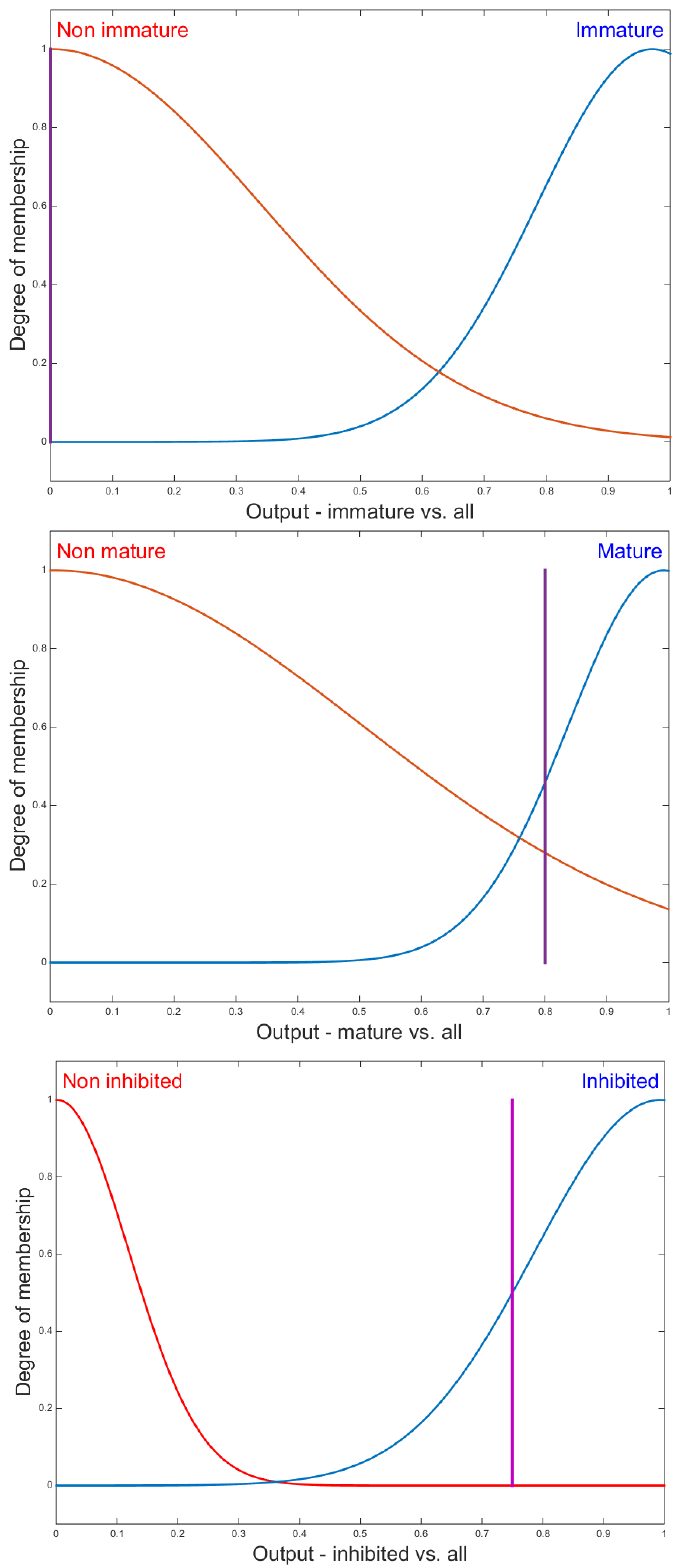
Figure 11. Membership functions of fuzzy sets of the FIS2 outputs. The vertical line corresponds to the defuzzification of the input corresponding to a 50% inhibited and 46% mature cell.